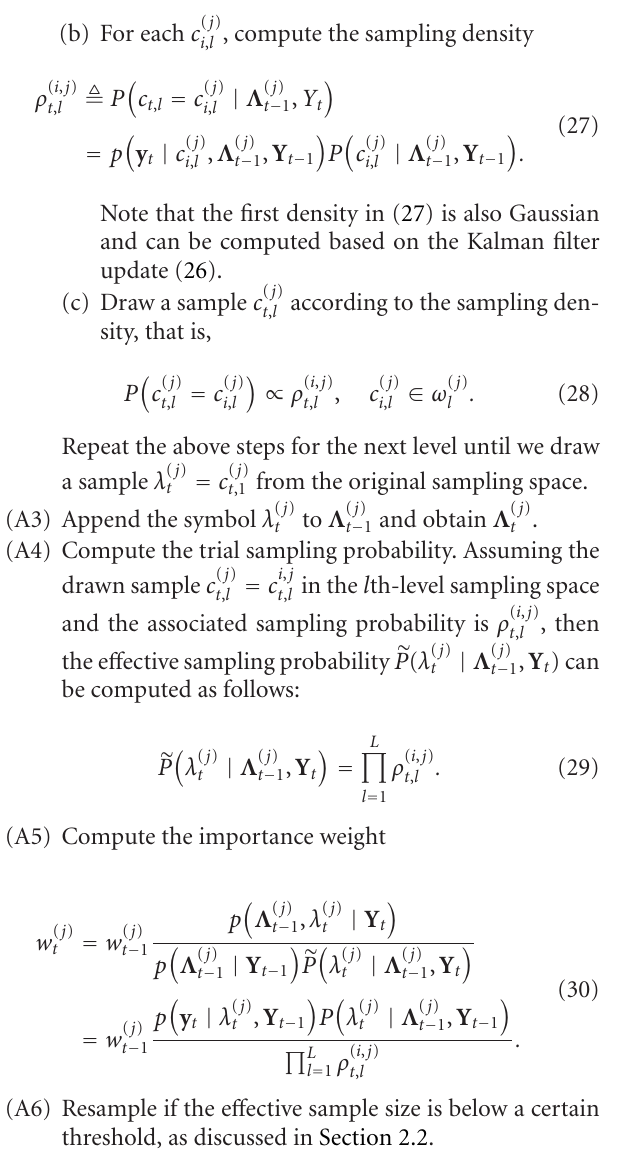
Algorithm 4 (delayed multilevel MKF). Suppose, at time ( t